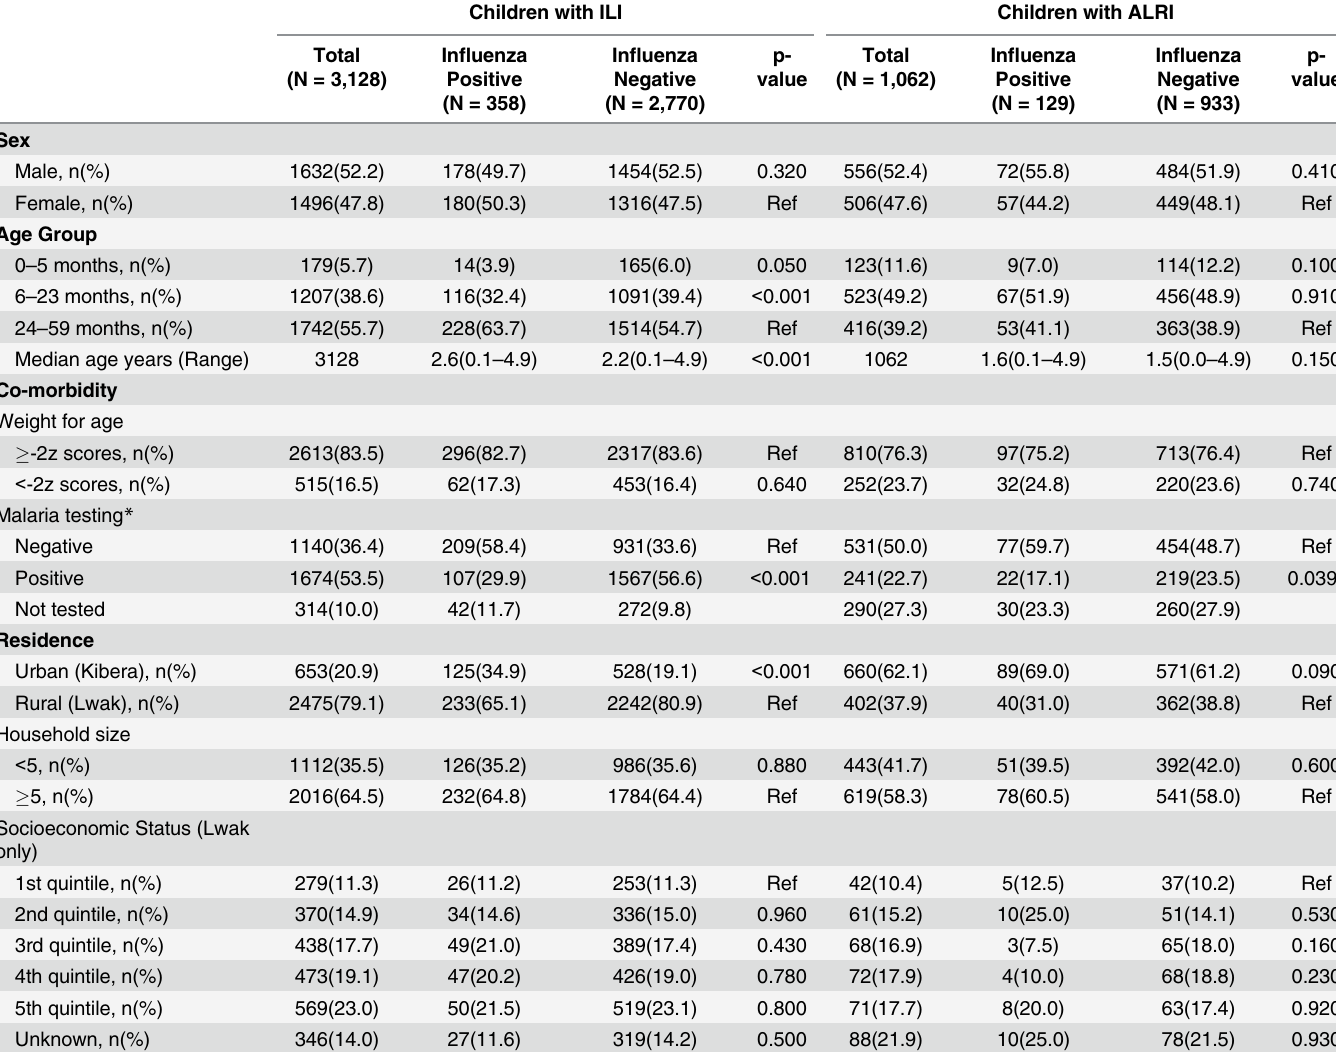
Table 2. Characteristics of Children with Influenza-like Illness (ILI) or Acute Lower Respiratory Tract Illness (ALRI) by Influenza Test Result, 2008 – 2012. Children with